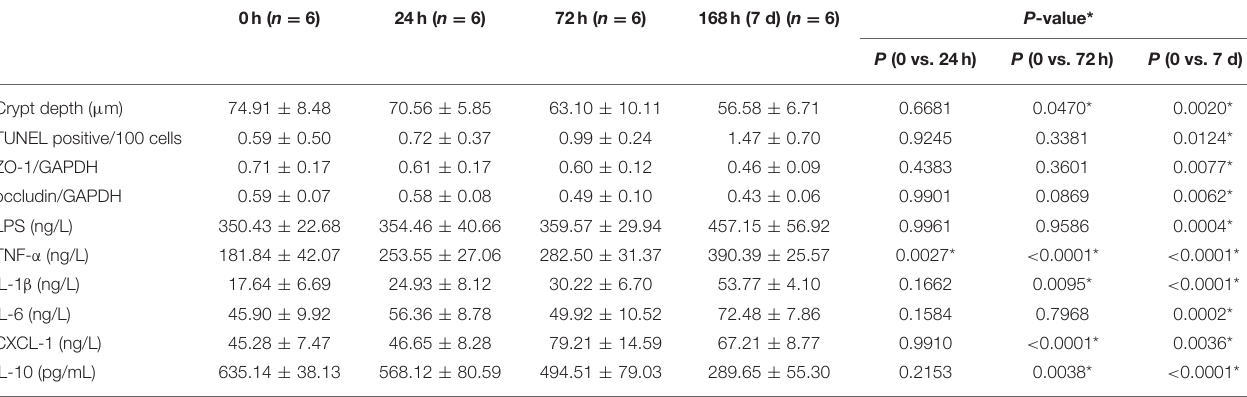
TABLE 2 | ANOVA analysis and Dunnett’s post hoc test of time-dependent gut histopathological injury, enterocyte death, gut barrier dysfunction, endotoxemia, and gut inflammation induced by 40% of